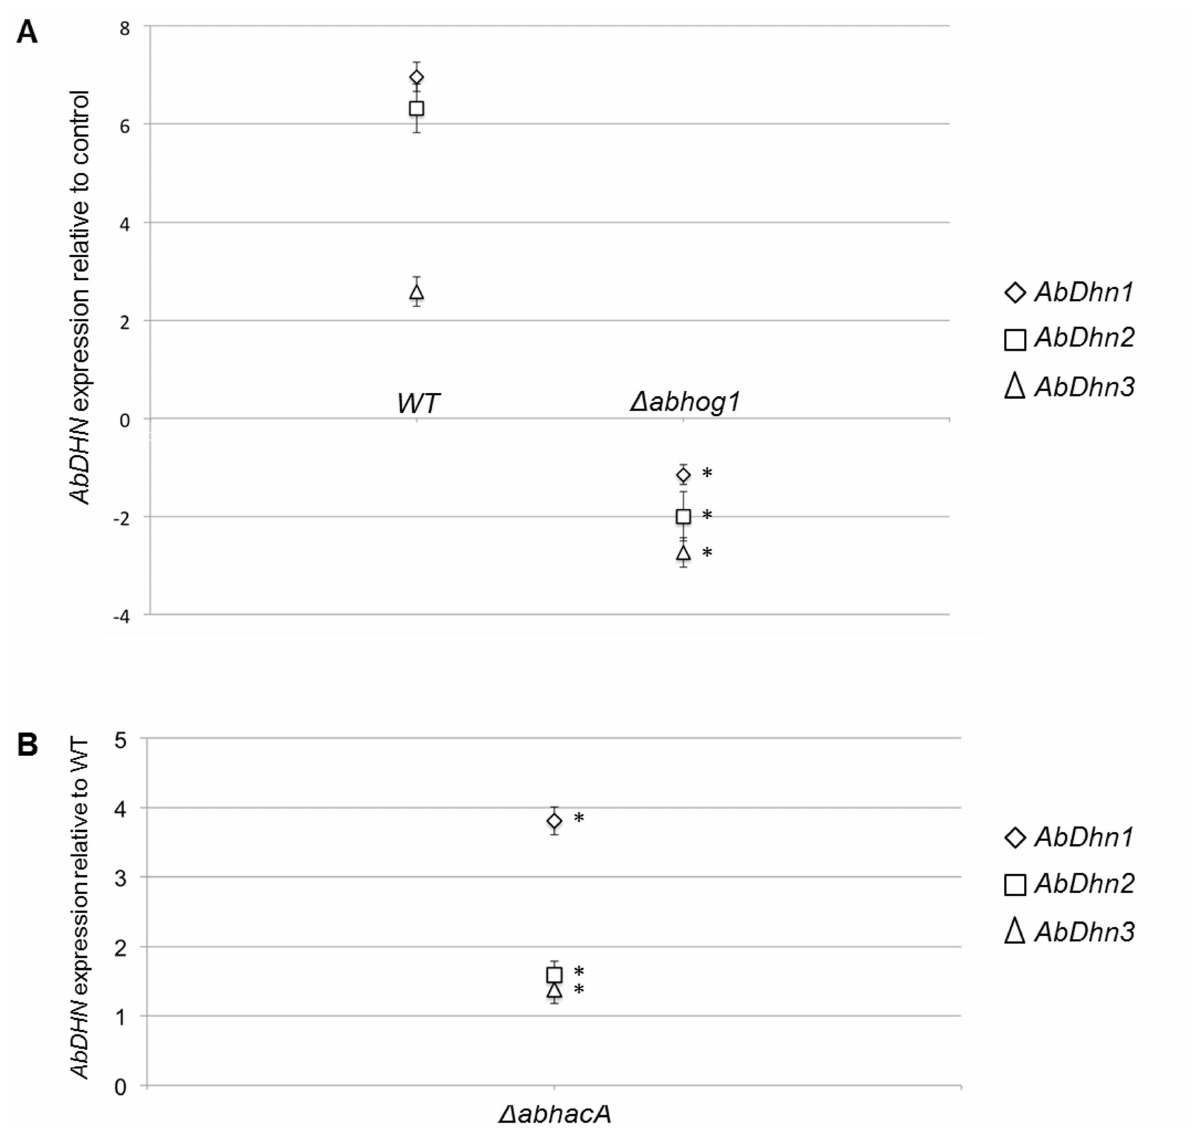
Figure 5. Expression of AbDhn genes in different genetic backgrounds estimated by real-time PCR. A: A. brassicicola wild-type (WT) and D abhog1 strains were exposed to 350 mM NaCl for 30 min prior RNA extraction. For the three AbDhn genes, expression induction is represented as a log 2 ratio (fold induction) of their relative expression under stress condition to their relative expression in the control without stress. B: Basal transcript levels of AbDhn genes in the D abhacA mutant relative to their expression levels in the reference wild-type strain Abra 43 (Log 2 values). Each value is the mean of two independent experiments, each with three replicates. Asterisks indicate values that are significantly ( P , 0.01) different than that of the wild-type.